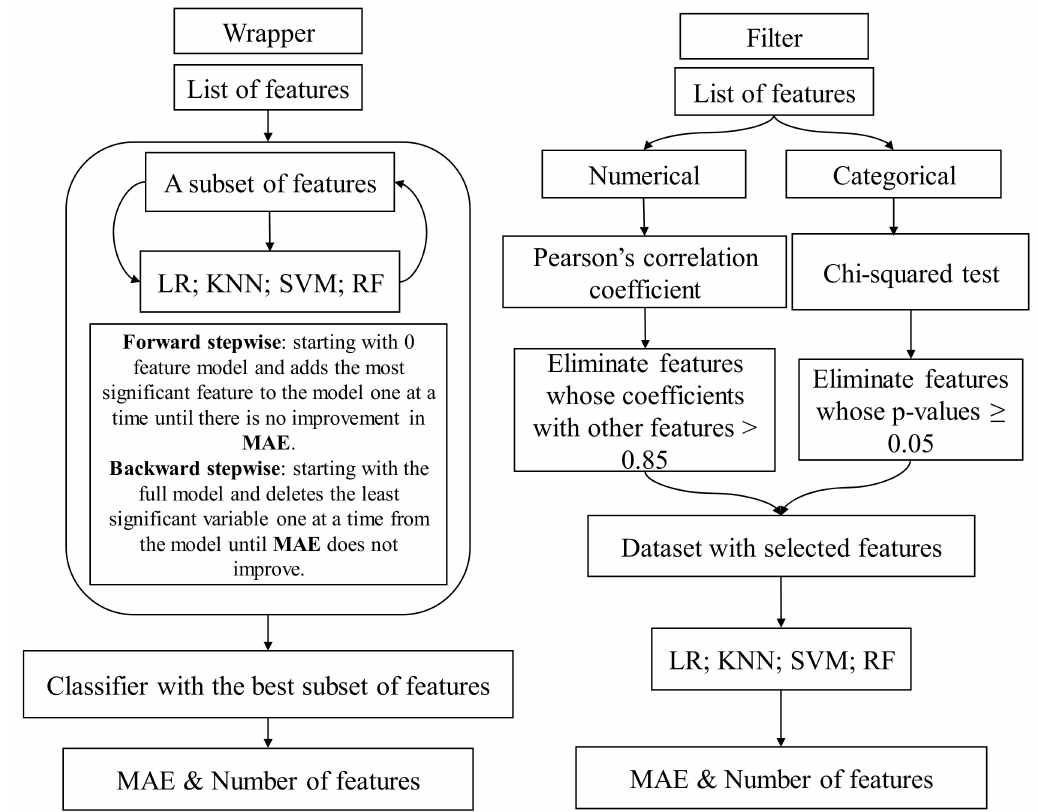
Figure 1. The methodology proposed for credit scoring: classification algorithms used (LR, SVM, KNN, RF) trained with different feature selection